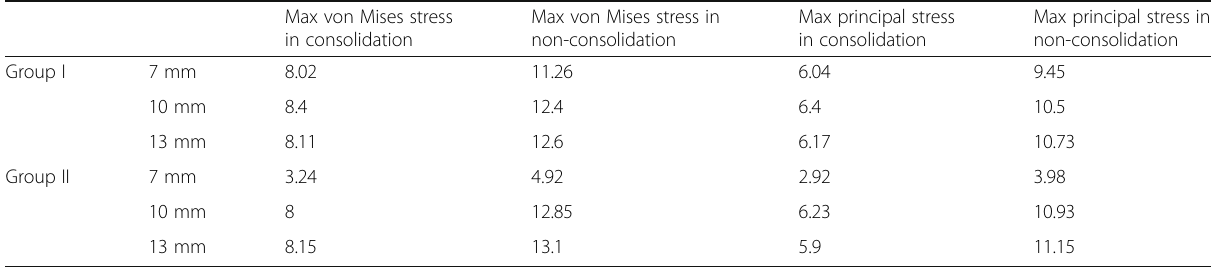
Table 10 Stresses on teeth (laterals) in group I and group II consolidated and non-consolidated